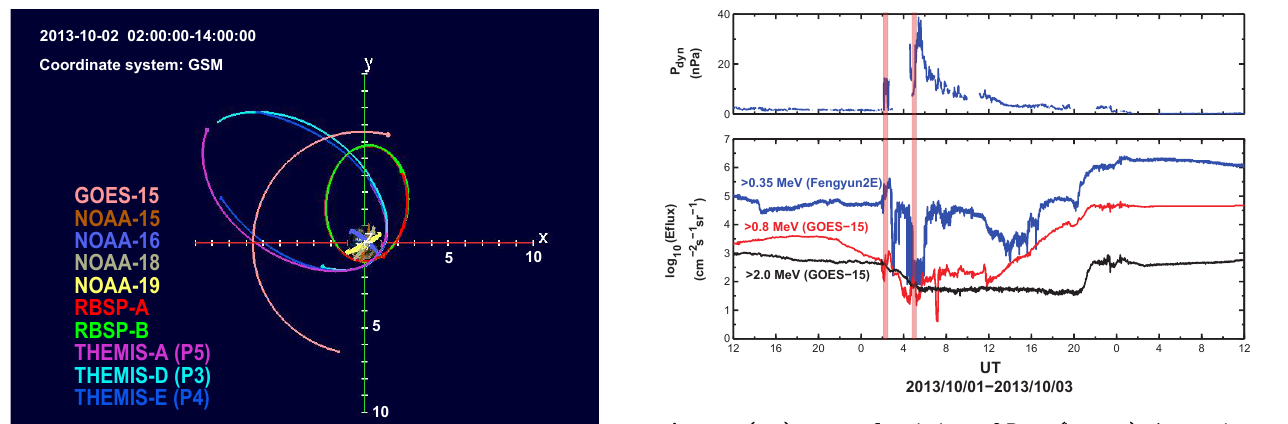
Figure 4. (top) Temporal variations of P dyn . (bottom) Observations of radiation belt electron fluxes at the geostationary orbit by two satellites, i.e., GOES-15 and FengYun 2E, for three specific energy channels: (blue) >0.35MeV, (red) >0.8MeV, and (black) >2MeV. The two vertical lines denote the start time of the two intense P dyn